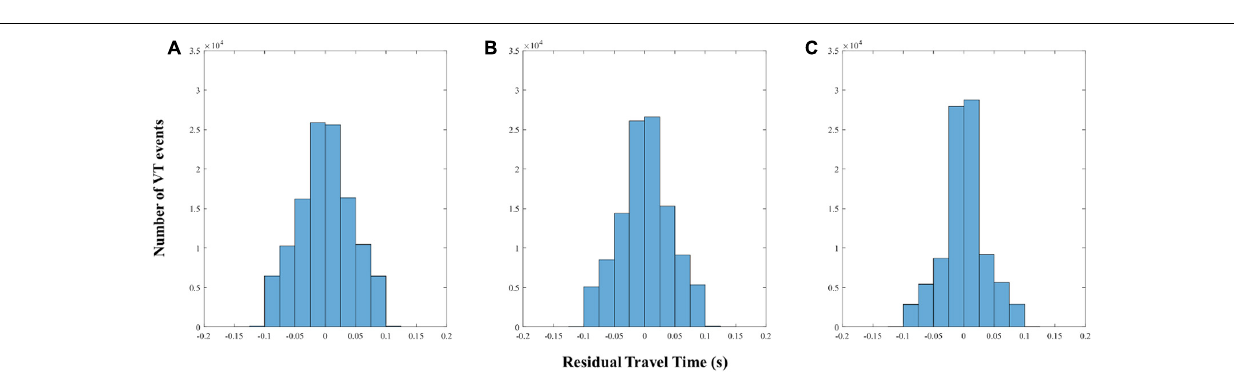
FIGURE 7 | Travel time residual of hypocenters for each step determined in this study; i.e., (A) initial locations for all events, (B) after updated 1D velocity model, and (C) after DD